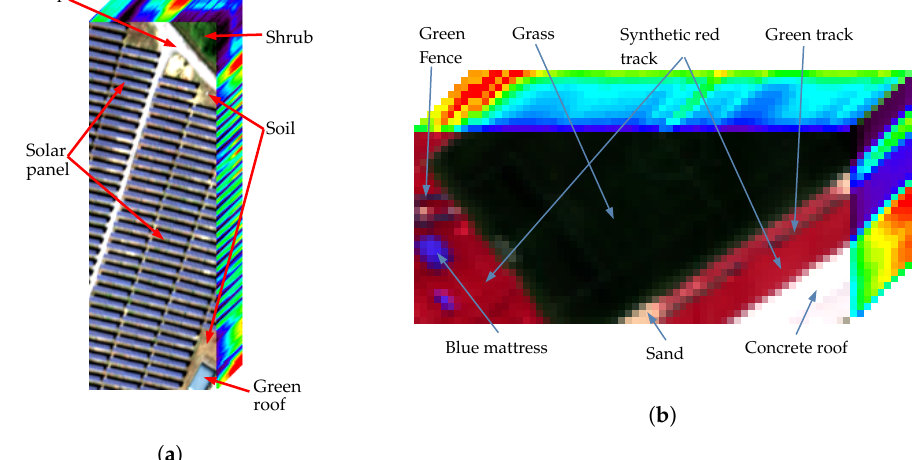
Figure 6. Airborne HS images: ( a ) 55 cm GSD Mauzac HS image, ( b ) 2 m GSD Basel HS image.